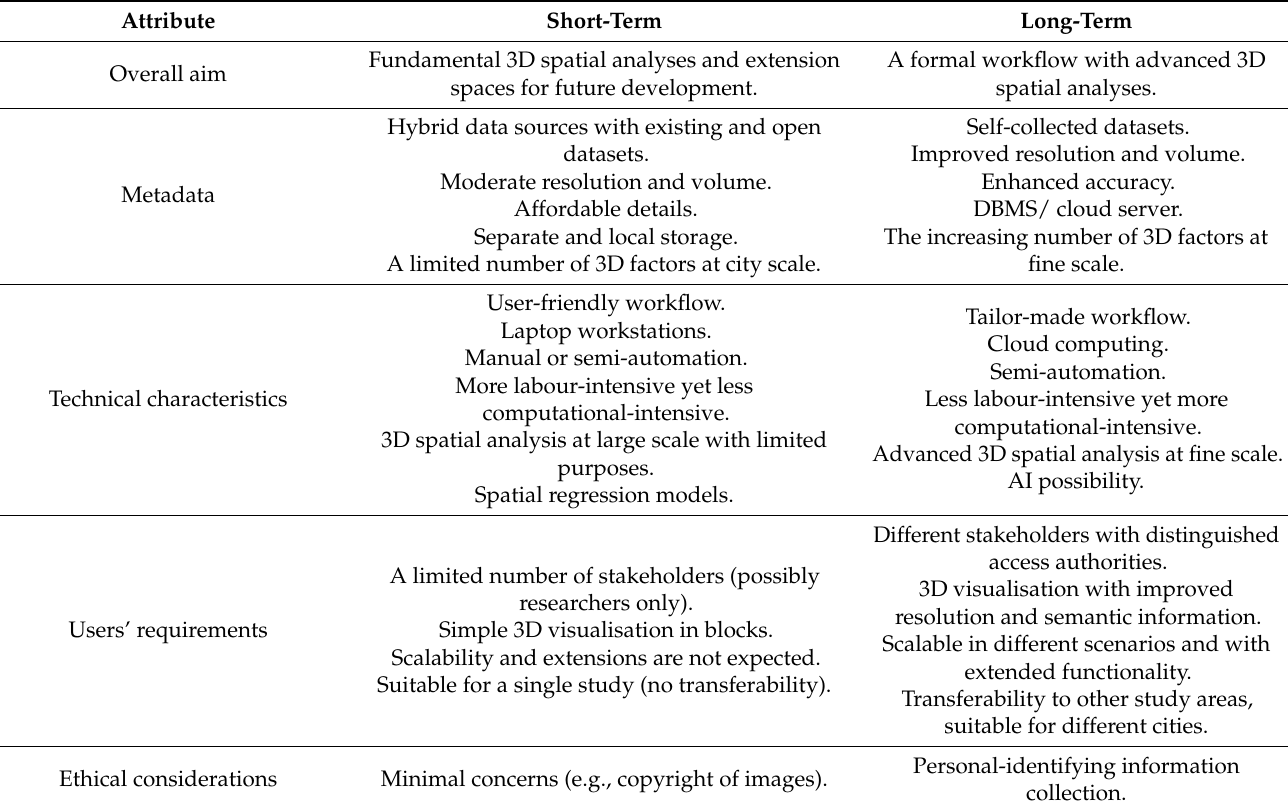
Table 5. The highlights of short-term and long-term